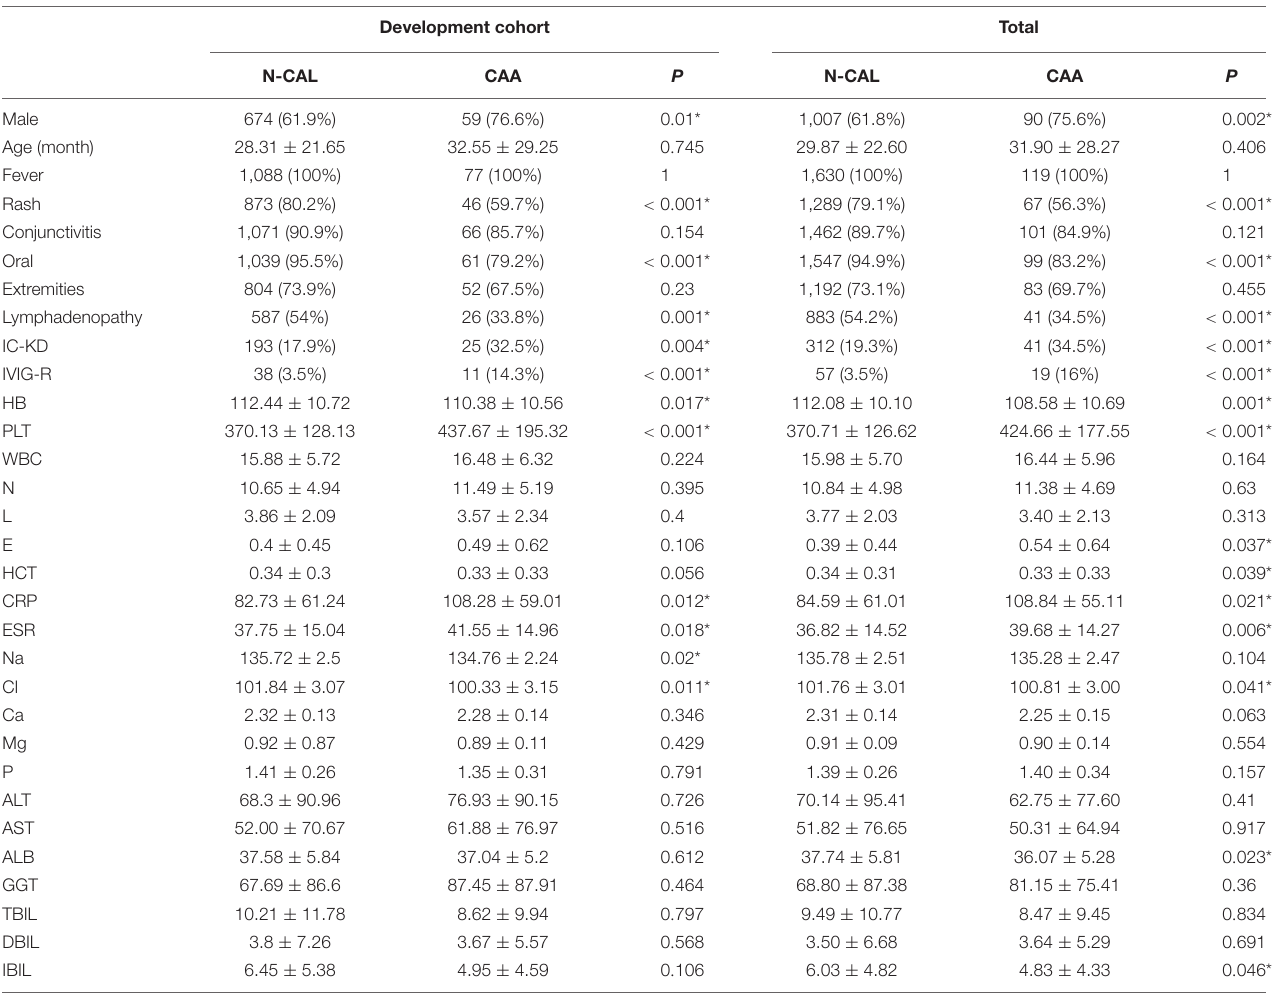
TABLE 1 | Demographic and clinical